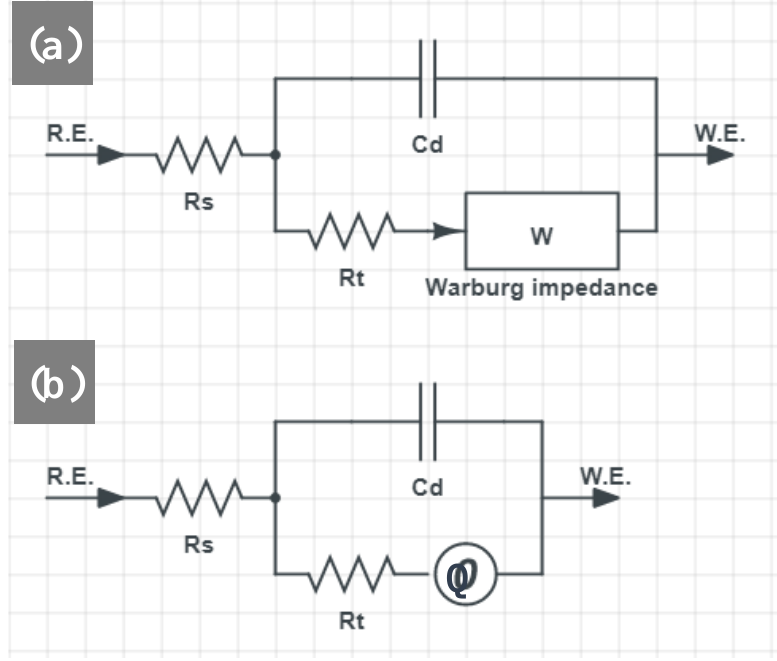
Figure 6. Equivalent circuit impedance for ( a ) conventional rebar, and ( b ) DP rebar. Rebar, reinforced steel bars; DP, dual phase.